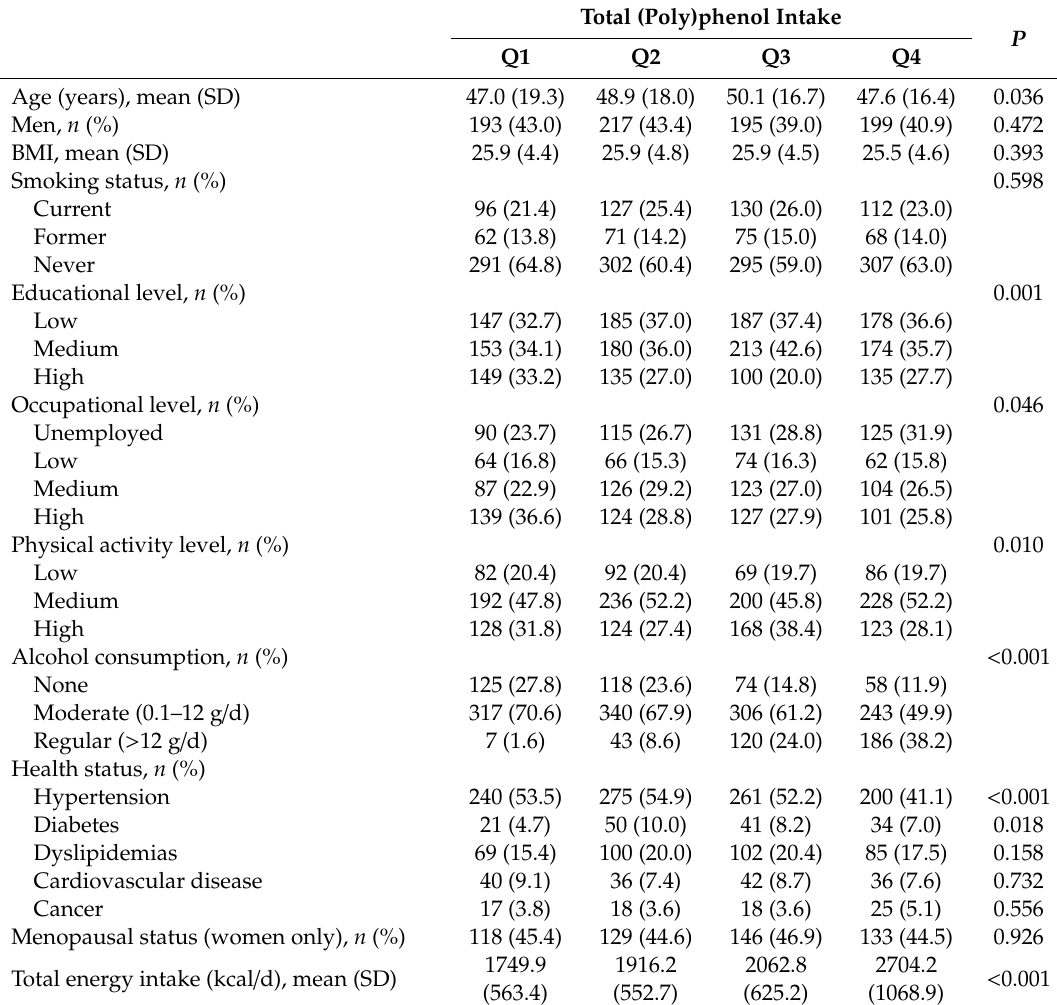
Table 1. Background characteristics of participants in the MEAL cohort by quartiles of total (poly)phenol intake